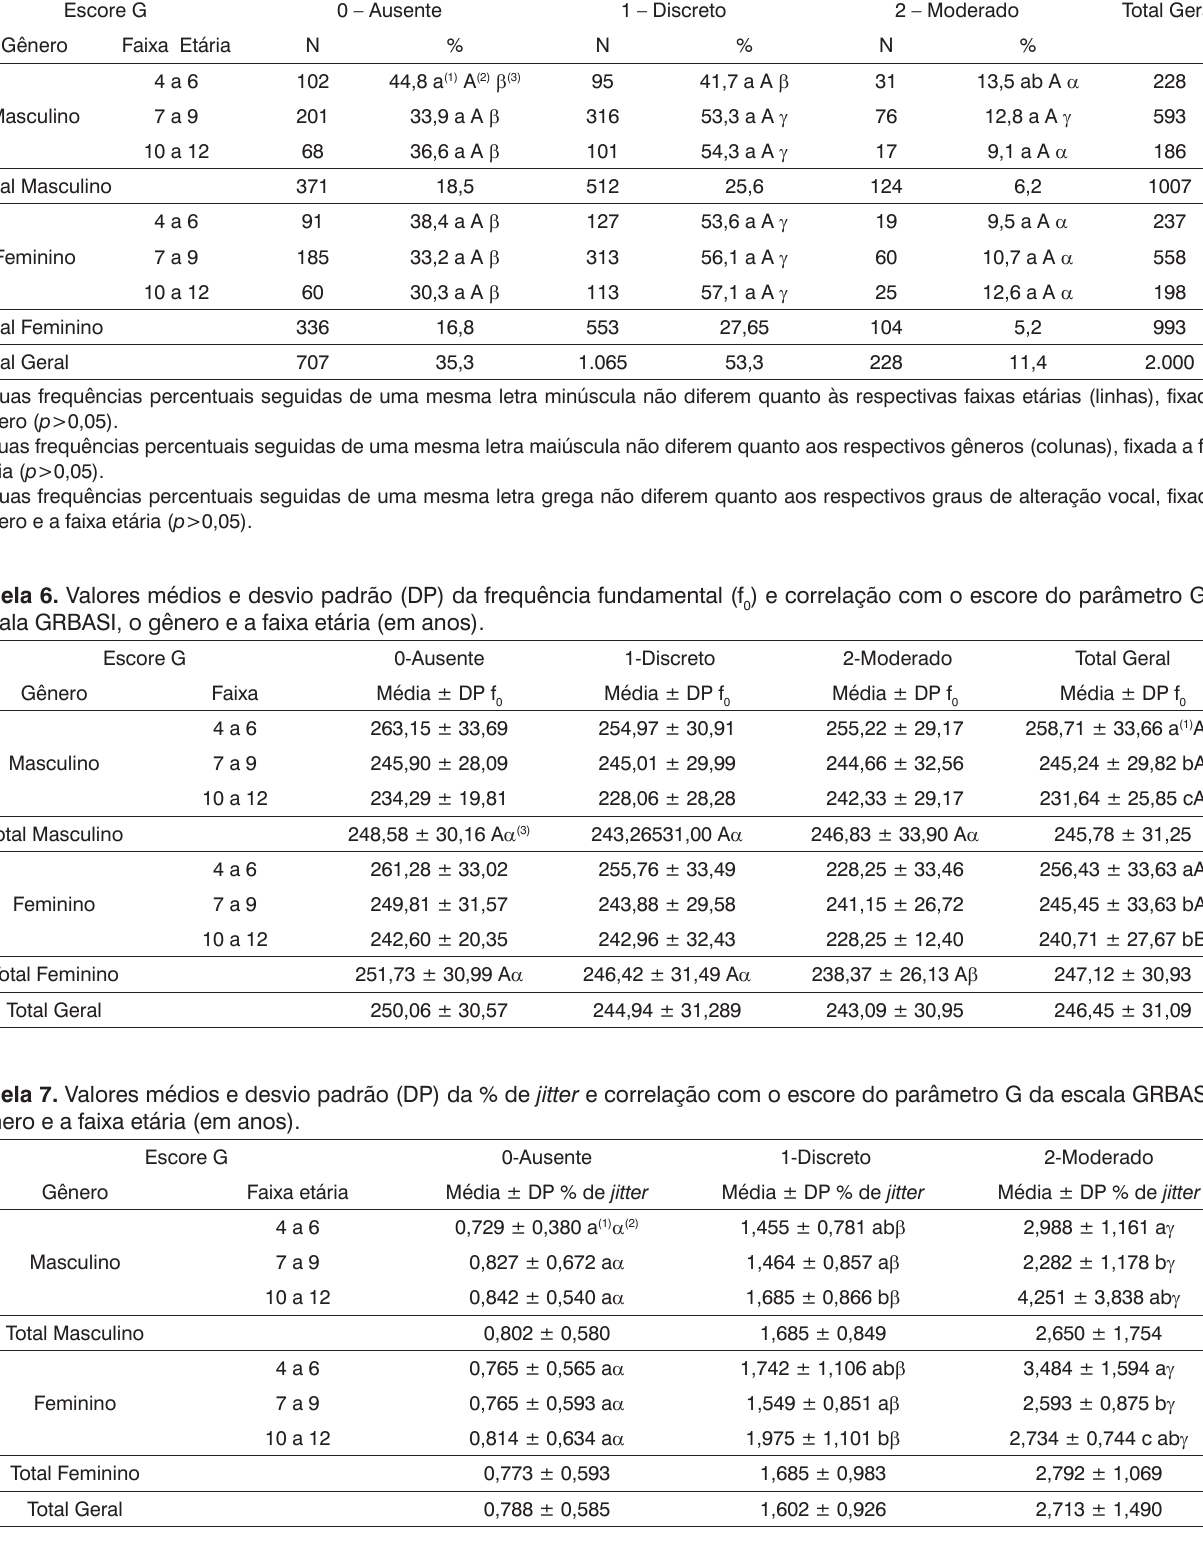
Tabela 5. Grau de alteração da voz baseado na pontuação do parâmetro G da escala GRBASI de acordo com a faixa etária (em anos) e o gênero.